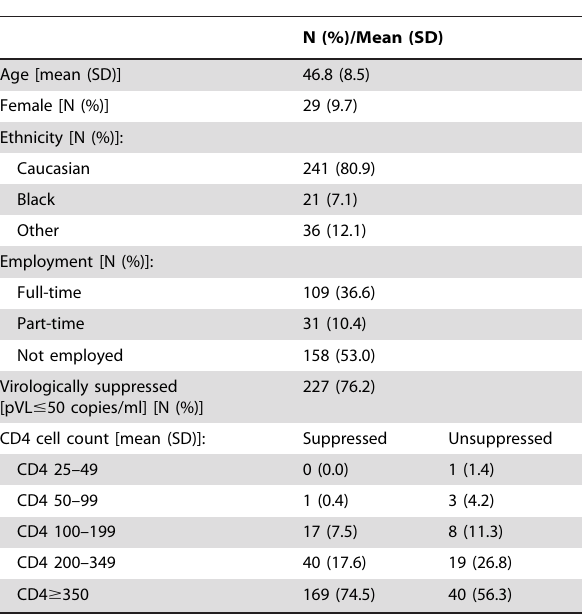
Table 2. Patient